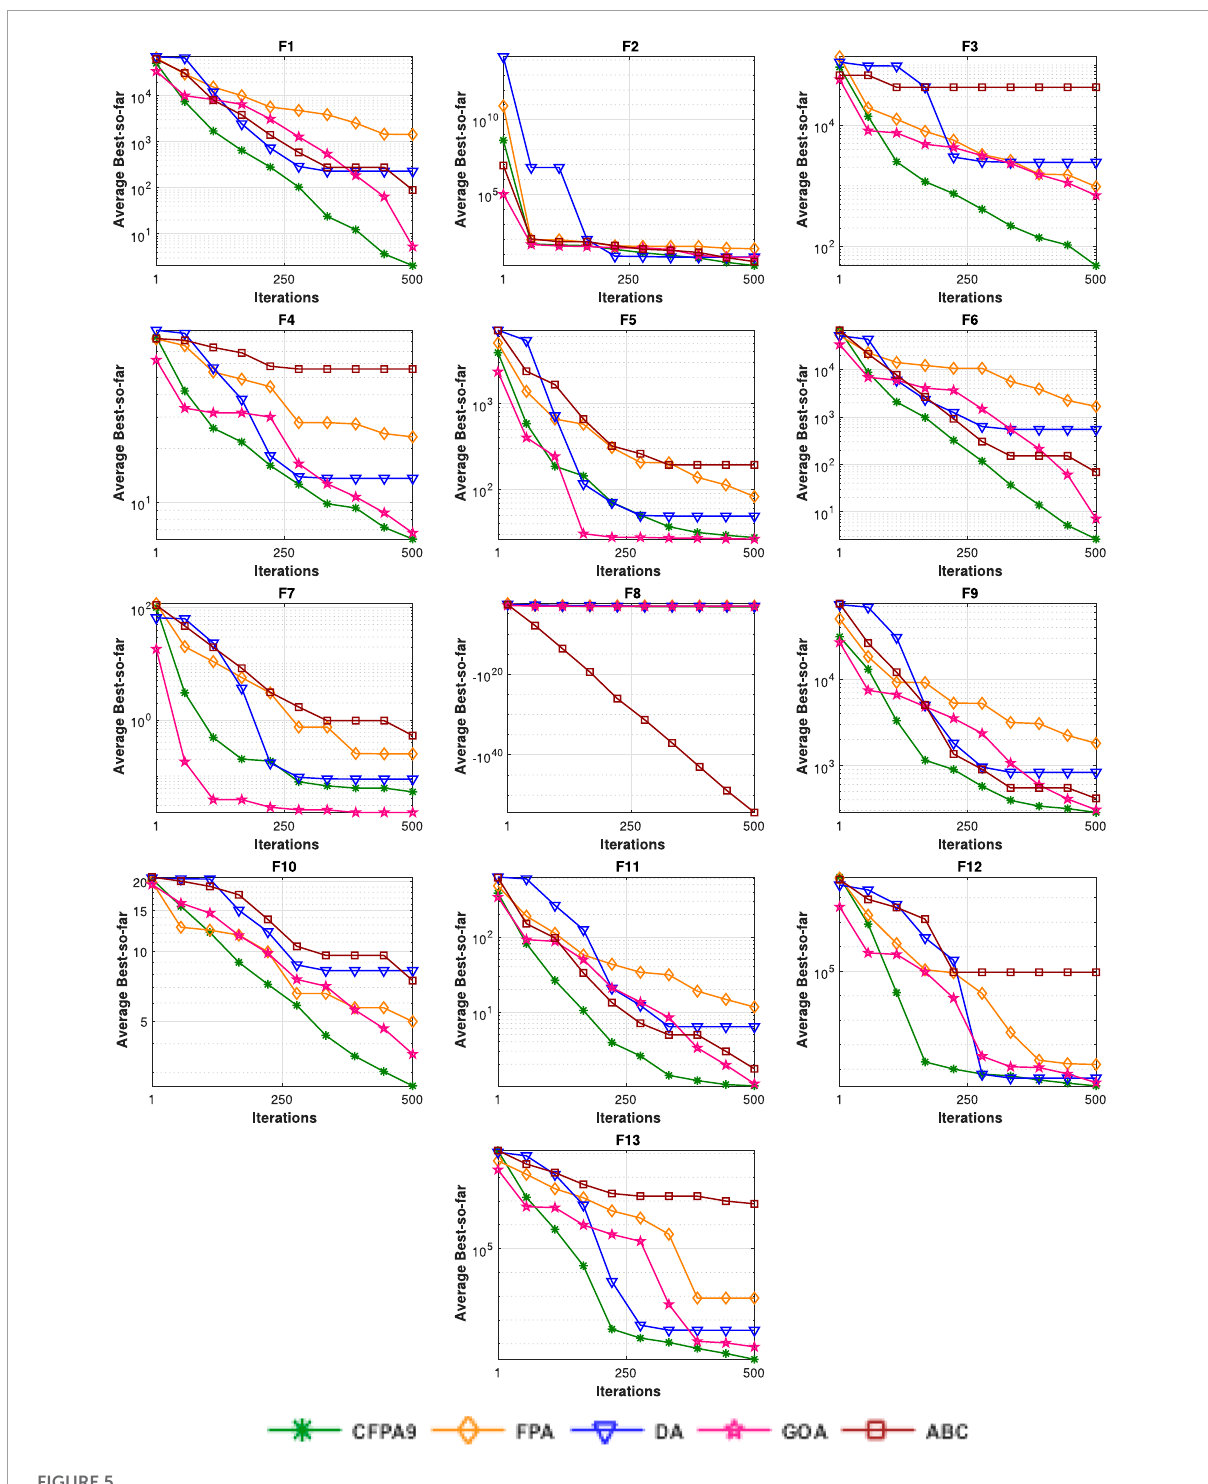
FIGURE 5 Convergence curves of CFPA9 vs. well-known approaches for benchmark